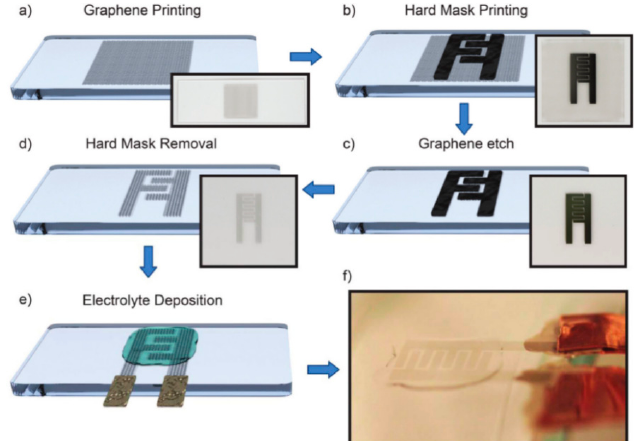
Figure 7. A schematic of a transparent type supercapacitor prepared by inkjet printing graphene ink. ( a ) Printing of graphene ink on a substrate; ( b ) Screen printing of silver ink as a current collector; ( c ) Plasma etching; ( d ) Removal of a mask; ( e ) Dripping the gel electrolyte; ( f ) Photographs of printed supercapacitors. Reproduced from [58], with permission from Royal Society of Chemistry, 2017.